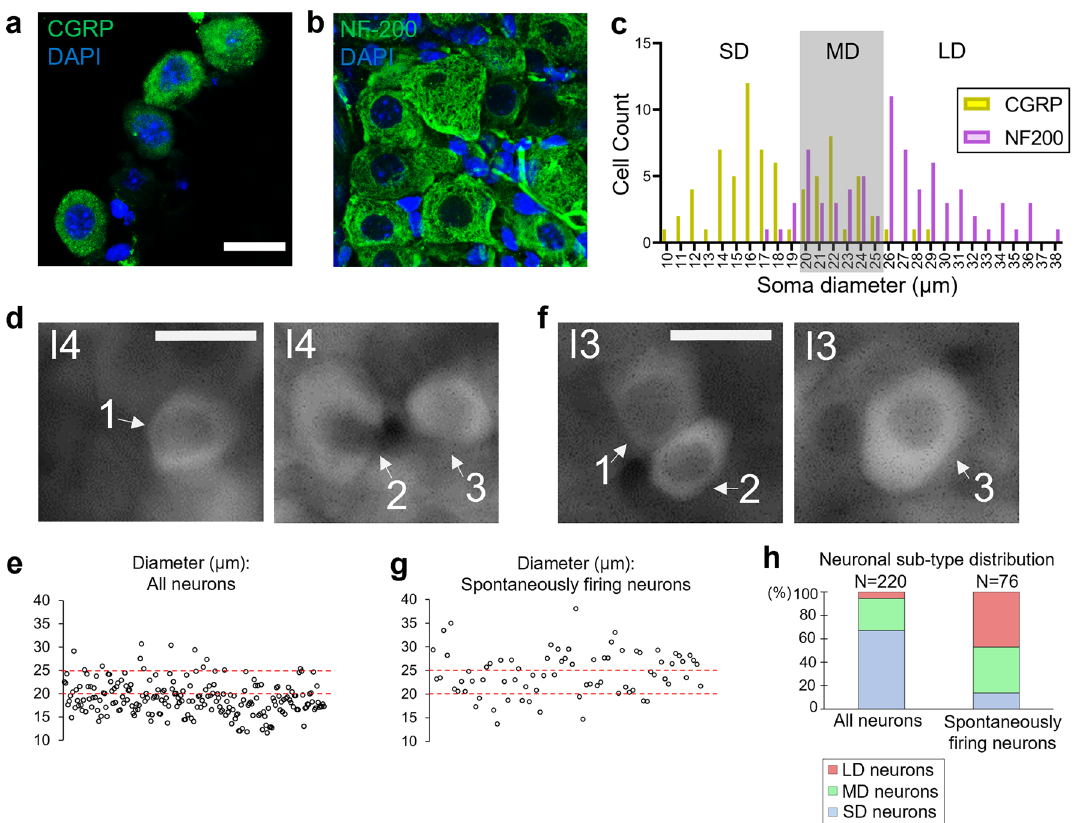
Figure 4. Spontaneous activity in neonatal TG is majorly exhibited by medium-to-large diameter neurons. ( a , b ) Representative images showing CGRP + ( a ) and NF-200 + ( b ) neurons in 20 µm-thick longitudinal sections of mouse TG at P6. Nuclei were stained by DAPI. ( c ) Distribution of soma-diameter of CGRP + and NF-200 + neurons (CGRP + : n = 74 neurons, NF-200 + : n = 75 neurons, 2 animals each). SD, MD, and LD: small, medium, and large-diameter neurons, respectively. ( d ) Stack images as the sum of all 600 frames recorded over a 10 min duration of ex vivo imaging when neurons were subjected to high potassium buffer (Image 4 (I4), L3) for three exemplary ROIs. Diameter of ROIs 1, 2, and 3 is 18.6 µm, 25.5 µm, 18.4 µm, respectively. ( e ) Scatter plot showing the distribution of neurons activated by high potassium by the diameter of their soma. The lower dashed line represents the boundary of SD and MD neurons (20 µm). The upper dashed line represents the boundary of MD and LD neurons (25 µm). (n = 220 neurons, 2 animals). ( f ) Stack images as the sum of all 600 frames recorded over a 10 min duration of ex vivo imaging when neurons were perfused with EVB (Image 3 (I3), L3) for three exemplary ROIs. Diameters of ROIs 1, 2, and 3 are18.2 µm, 19.0 µm, 26.0 µm, respectively. ( g ) Scatter plot showing the distribution of spontaneously firing neurons by the diameter of their soma. (n = 76, neurons, 2 animals). ( h ) Stacked bar graph comparing the distribution of all neurons and spontaneously firing neurons based on their soma-diameter. The total number of neurons considered is indicated above the bars. Scale bars: 20